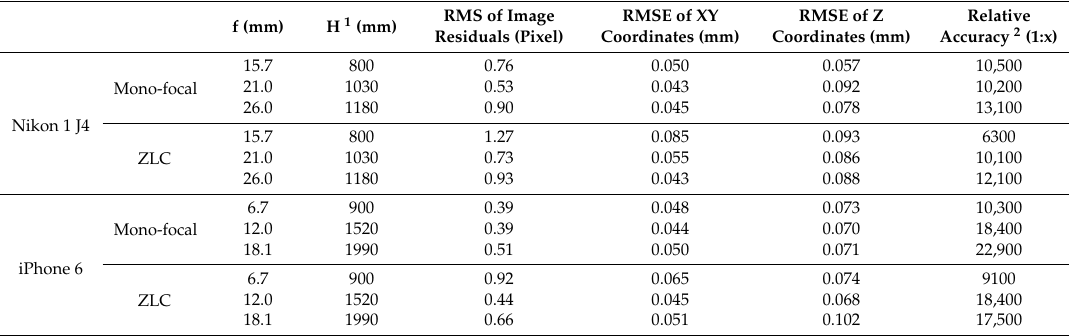
Table 3. Zoom lens vs mono-focal calibrations in terms of derived accuracy.